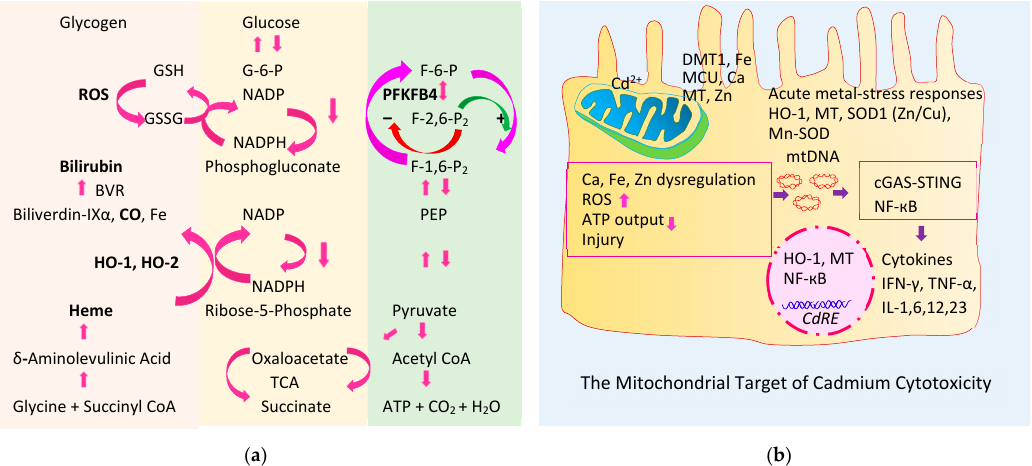
Figure 4. Heme-glucose crosstalk and mitochondrial target of cadmium. ( a ) Heme degradation cat- alyzed by HO-1 and HO-2 utilizes NADPH from pentose phosphate pathway. ( b ) Cadmium-in- duced kidney tubular cell death. Cd uses the Zn carrier metallothionein (MT) and transporters of Ca and Fe, mitochondrial calcium uniporter (MCU) and the divalent metal transporter 1 (DMT1) to reach the mitochondrial inner membrane [145]. There, Cd reduces ATP output and promotes reac- tive oxygen species (ROS) formation. Extensive damage causes a release of mitochondrial DNA (mtDNA). The DNA-sensing mechanism (cGAS-STING) and nuclear factor-kappaB (NF- к B) signal- ing pathways are activated, proinflammatory cytokines are released, and cell death ensues. Abbre- viation: BVR, biliverdin reductase; PEP, phosphoenolpyruvate; cGAS, cyclic GMP-AMP synthase; STING, stimulator of interferon genes; CdRE , Cadmium response element. 4.4. Exogenous HO-1 Inducers Several therapeutic drugs, such as statins (lipid lowering agents), rosiglitazone (anti- diabetic drug), aspirin (anti-inflammatory drug), paclitaxel and rapamycin (anti-cancer drugs), have been shown to induce HO-1 expression. The therapeutic efficacy of these drugs may be attributable, at least in part, to HO-1 induction [116,117]. A wide range of antioxidants from plant foods, such as curcumin, quercetin, tert- butylhydroquinone, and caffeic acid phenethyl ester, are HO-1 inducers, as are catechin (in green tea), α -lipoic acid (in broccoli, spinach), resveratrol (in red wine, grapes), carno- sol, sulforaphane (cruciferous vegetable), coffee diterpenes cafestol, and kahweol [138– 140,146–148]. Beneficial effects of consumption of these antioxidants could thus be medi- ated in part through the induction of HO-1 expression. Diet high in anti-oxidative and anti-inflammatory nutrients was associated with in- creased serum bilirubin levels and reduced oxidative stress and systemic inflammation [104]. Green tea consumed in usual amounts was found to increase HO-1 expression [149– 151]. One of the trials included only non-smoking diabetic subjects who had no history of metabolic complications and did not take regular food supplements [150]. Among 43 sub- jects, 23 had the long GT repeats (GT repeats ≥ 25; L/L genotype) type of the HO-1 pro- moter and another 20 had short GT repeats (GT repeats < 25; S/S genotype). According to Western blotting and the comet assay, HO-1 protein levels in circulating lymphocytes were increased by 40%, while the level of the DNA repair enzyme 8-oxoguanine glycosyl- ase (hOGG1) was increased 50% with DNA damage being reduced by 15%. Green tea